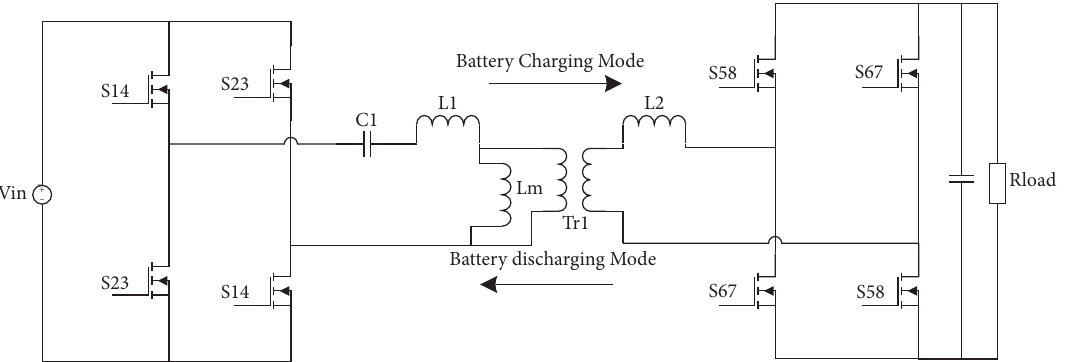
Figure 2: Schematic of the proposed isolated bidirectional CLLL resonant DC-DC converter.